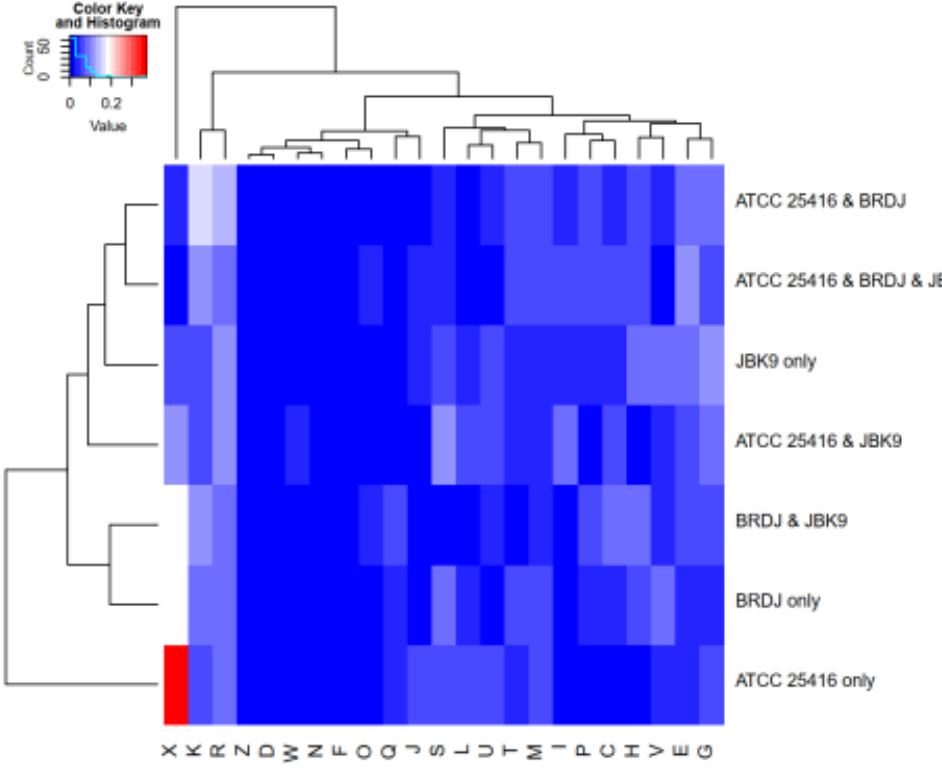
Figure 4. Heatmap based on core and strain-specific clusters of orthologous groups (COGs). The horizontal axis shows the group of shared or unique genes. The vertical axis corresponds to COG functional categories. The data is normalized (number of genes with related functions in the group/total number of genes in the group). COG functional categories: Translation, ribosomal structure and biogenesis (J), Transcription (K), Replication, recombination and repair (L), Cell cycle control, cell division, chromosome partitioning (D), Defense mechanisms (V), Signal transduction mechanisms (T), Cell wall/membrane/envelope biogenesis (M), Cell motility (N), Cytoskeleton (Z), Extracellular structures (W), Intracellular trafficking, secretion, and vesicular transport (U), Posttranslational modification, protein turnover, chaperones (O), Mobilome: prophages, transposons (X), Energy production and conversion (C), Carbohydrate transport and metabolism (G), Amino acid transport and metabolism (E), Nucleotide transport and metabolism (F), Coenzyme transport and metabolism (H), Lipid transport and metabolism (I), Inorganic ion transport and metabolism (P), Secondary metabolites biosynthesis, transport and catabolism (Q), General function prediction only (R), Function unknown (S).